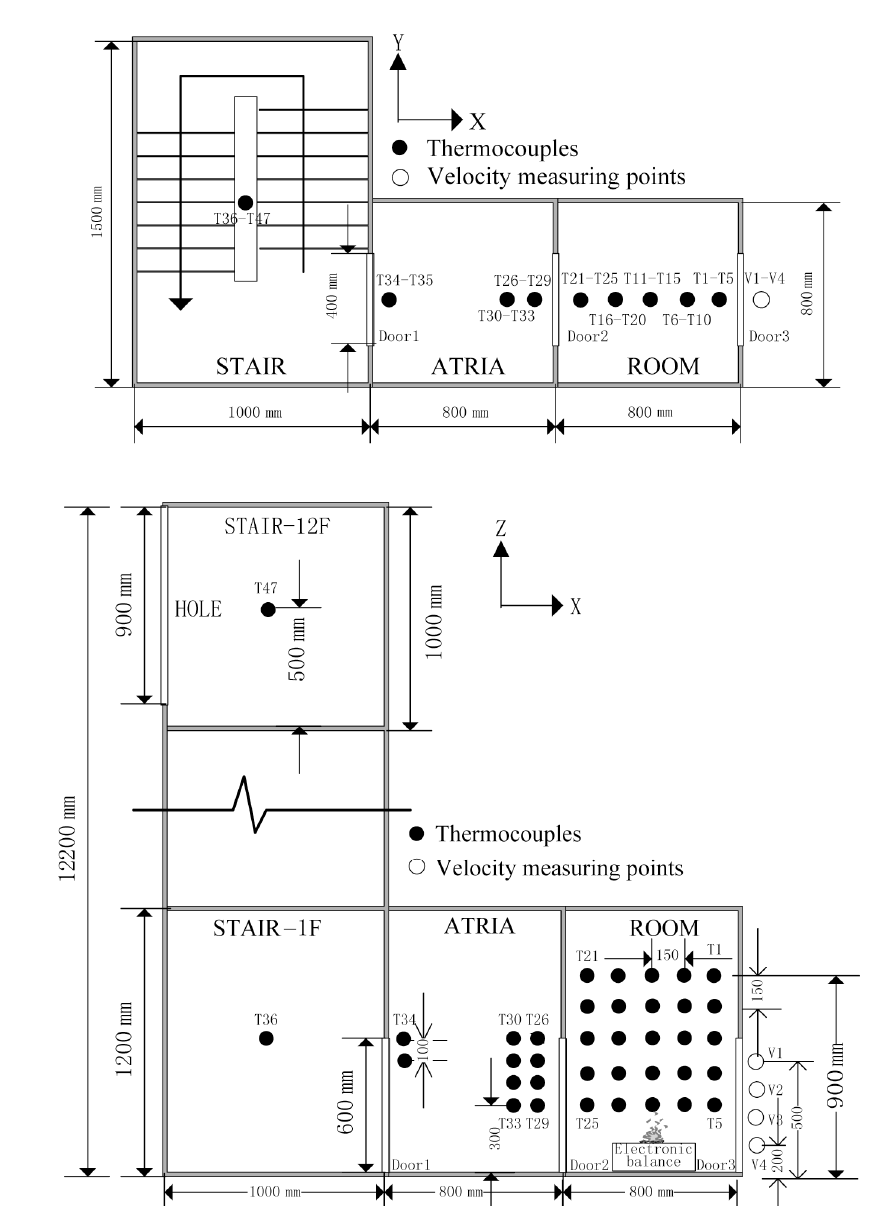
Fig. 2. Locations of thermocouples and velocity measuring points: a) Top view; b) Side